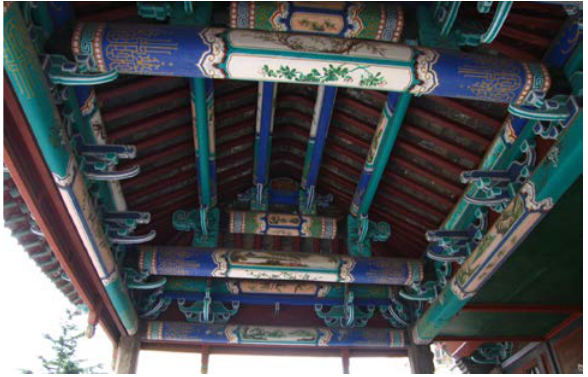
Figure 14. Frame of the Theater Pavillion in Great